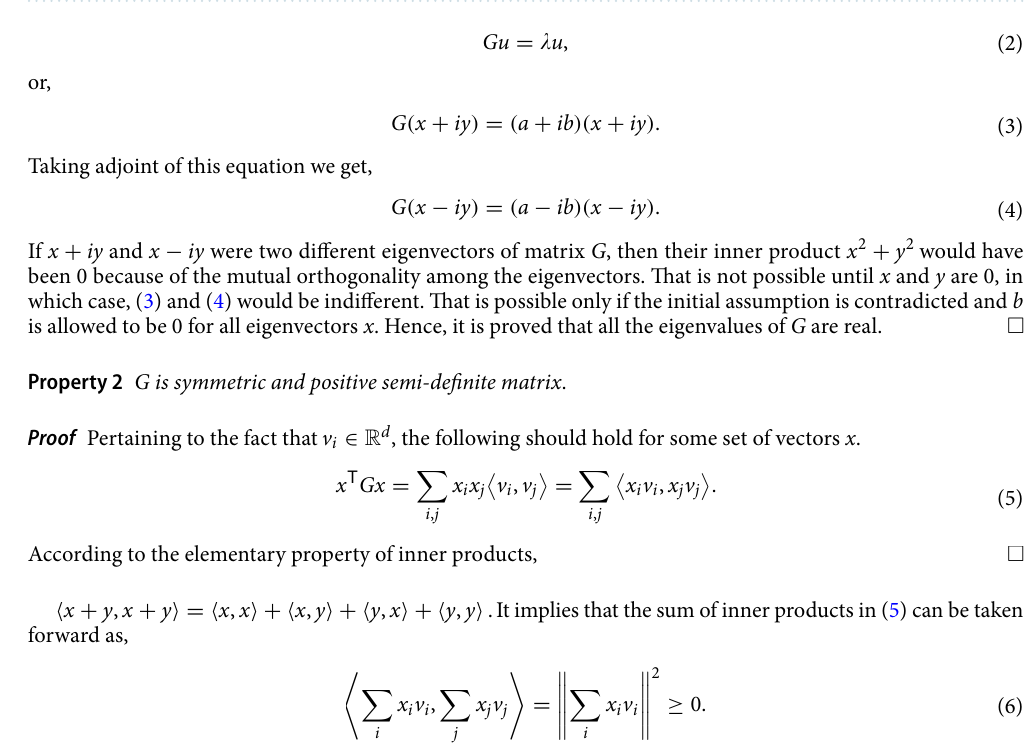
Figure 1. Schematic flow diagram of the proposed approach for cancer subtypes